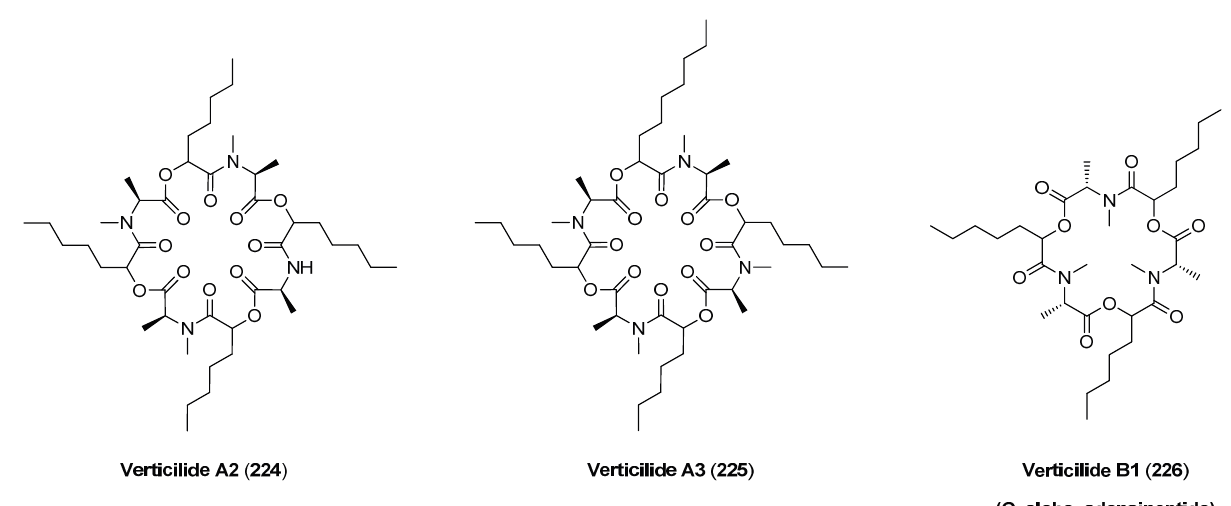
Figure 25. Structures of verticilide analogues 224 – 226